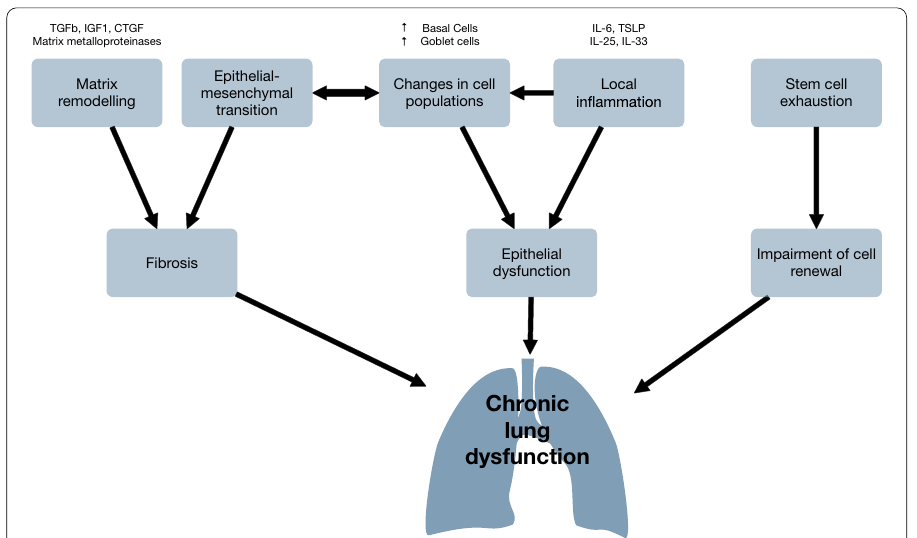
Fig. 2 Mechanisms of chronic lung dysfunction after critical illness. Local inflammation, changes in cell populations and matrix remodeling promote a pro‑fibrotic state that may cause long‑term respiratory impairment. TRPV4 transient receptor potential cation channel, subfamily V, member 4. BBB blood–brain barrier, DRD2 dopamine receptor type